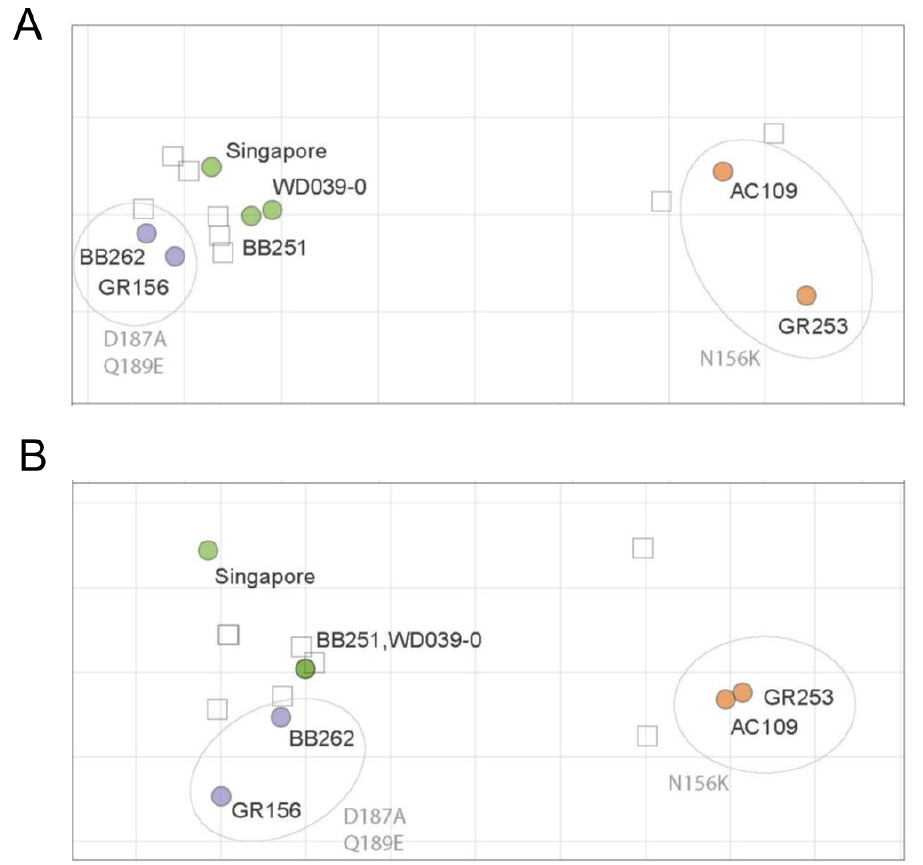
Figure 3. HI and neutralization antigenic maps of A(H1N1)pdm09 viruses. HI ( A ) and neutralization ( B ) titers of ferret antisera were used to construct antigenic maps. Virus names are black, whereas amino acid substitutions are grey. Viruses are abbreviated as follows: A/Singapore/GP1908/2015 (Singapore); A/Tokyo/UT-WD039-0/2019 (WD039-0); A/Tokyo/UT-BB251/2019